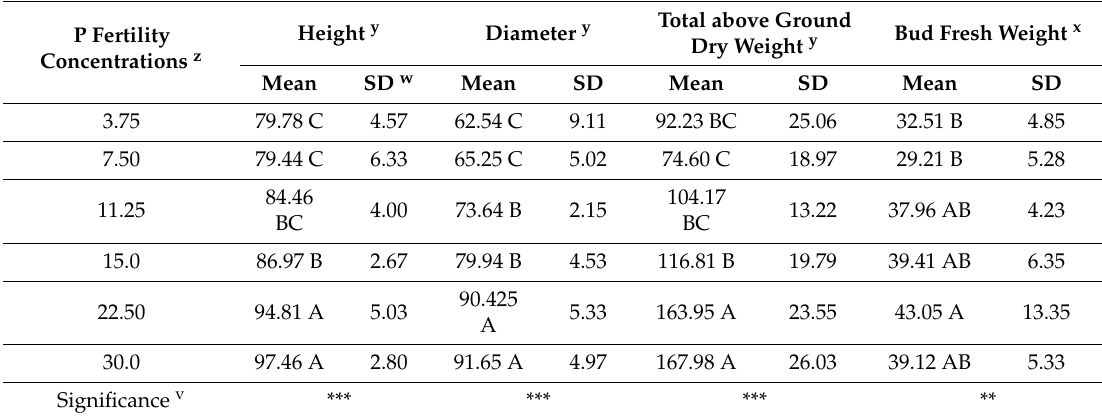
Table 6. The impacts of phosphorus (P) fertility on plant growth metrics of C. sativa “BaOx” after eight weeks of critical night length (CNL)